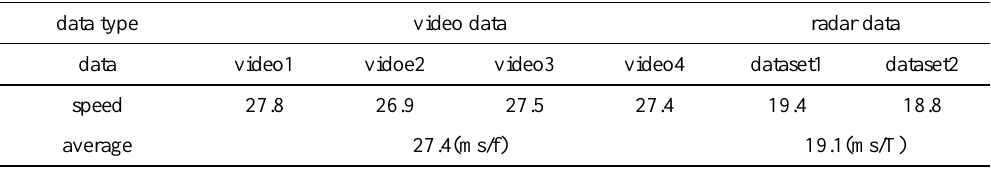
Table 3. Processing speed of this method and the traditional